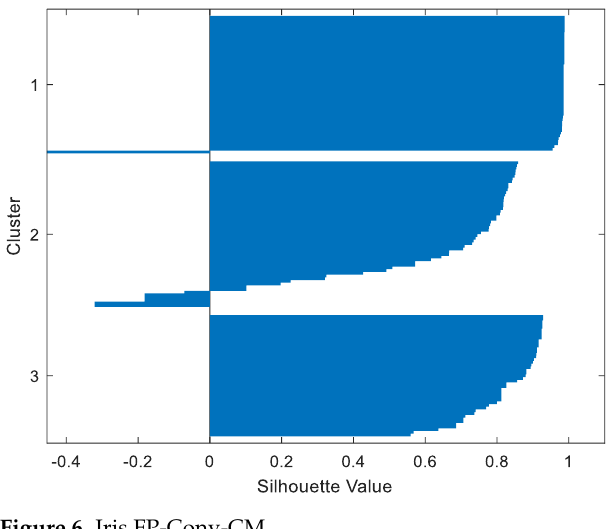
Figure 6. Iris FP-Conv-CM.